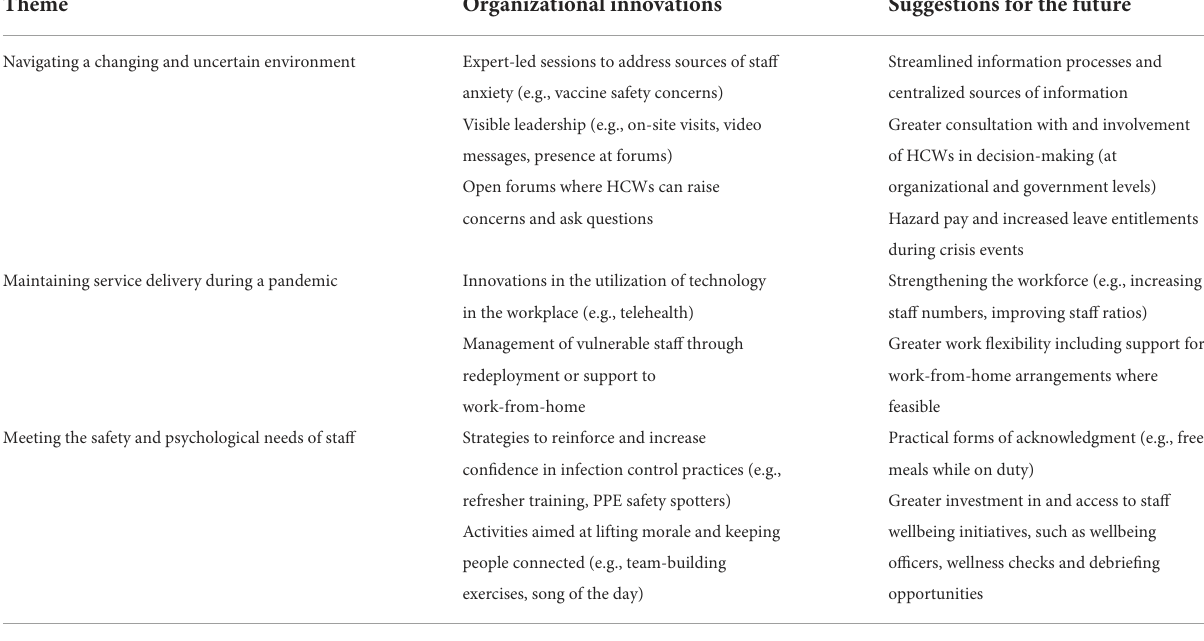
TABLE 2 Summary of organizational innovations and suggestions for the